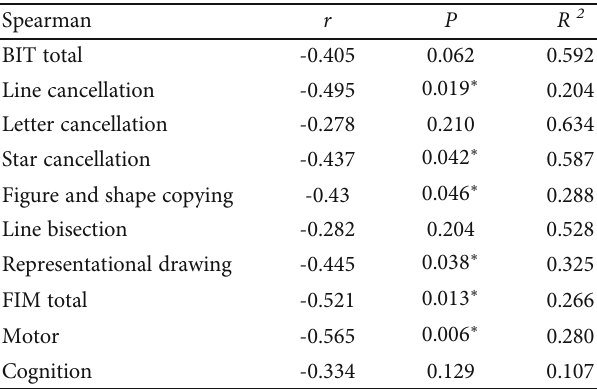
Table 4: Correlation between KF-NAP and other assessments. Spearman